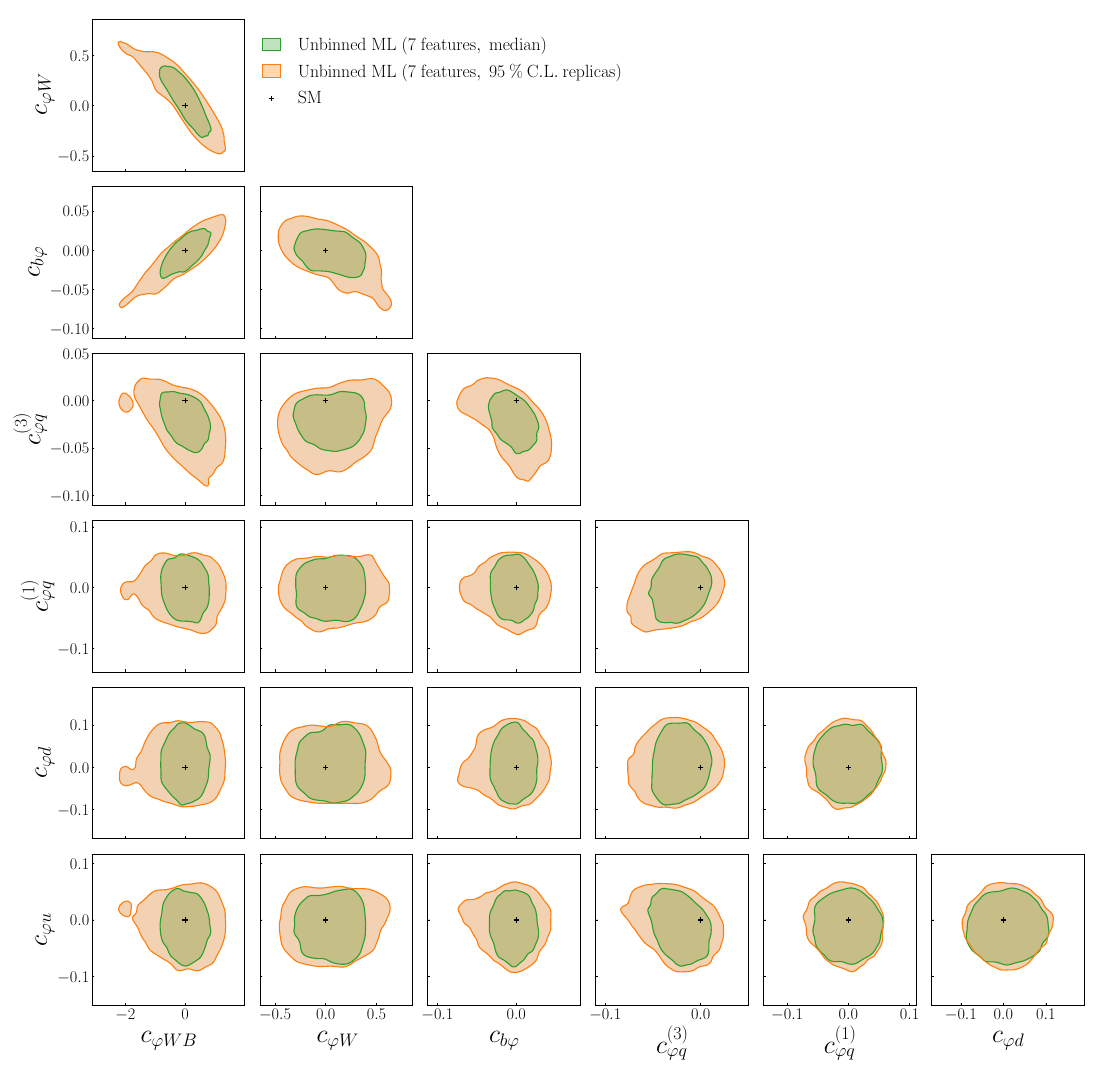
Figure 19. Same as figure 18 for Higgs associated production with a Z boson, now for the 95% CL